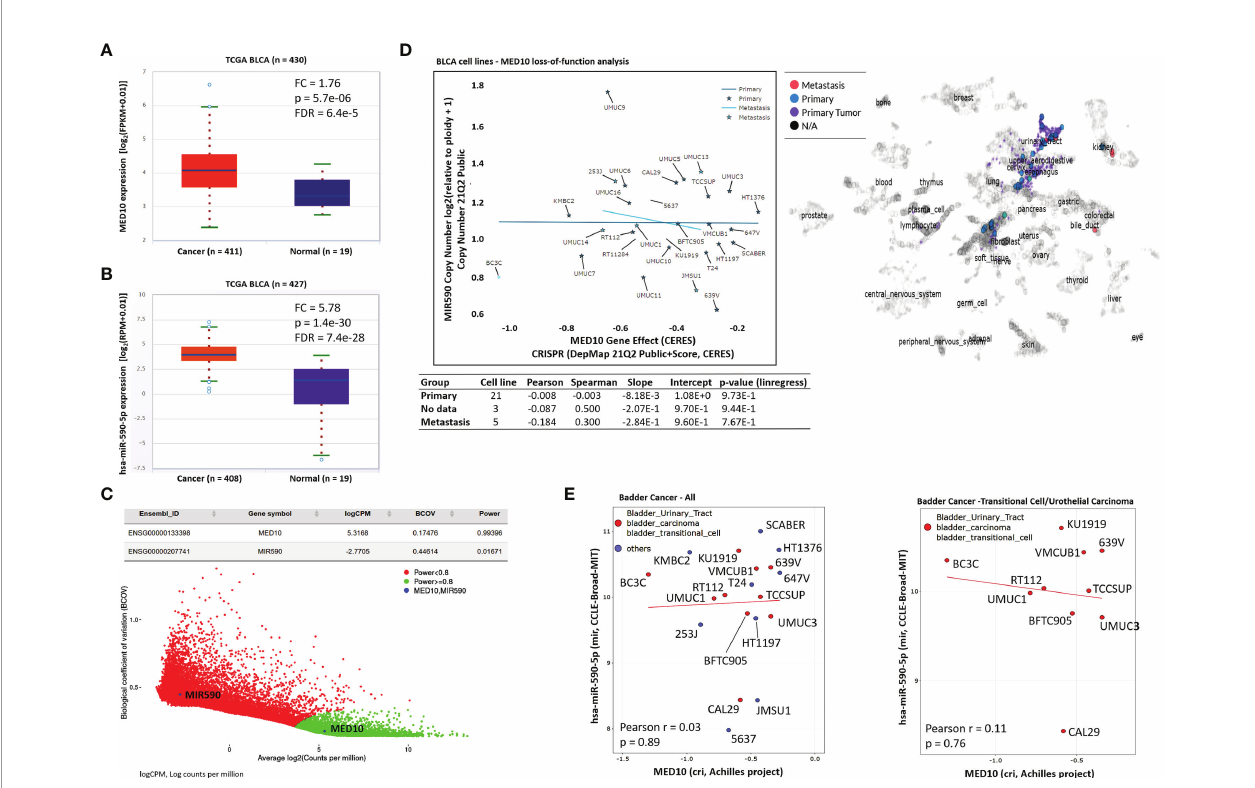
FIGURE 5 | Targeting MED10 elicits downregulation of hsa-miR-590-5p expression preferentially in metastatic, transitional cell (urothelial) carcinoma cells. Box and whisker plots of the differential expression of (A) MED10 or (B) hsa-miR-590-5p in cancer and normal samples from the TCGA BLCA cohort. (C) Scatter-plot of the biological coef fi cient of variation (BCOV) against the average abundance of MED10 and MIR590 in the GSE81157 aggressive bladder cancer cohort. (D) Graphical representation of the effect of MED10 loss of function on hsa-miR-590 copy number in 29 metastatic or primary BLCA cell lines from the 21Q2 Public cohort (left) . Chart showing the spatial distribution of the BLCA cell lines according to metastasis status (right) . Visualization of the effect of MED10 knockout on hsa-miR-590-5p expression in (E) mixed pool of BLCA cell lines (left) , or purely bladder transitional/UC cell lines (right)